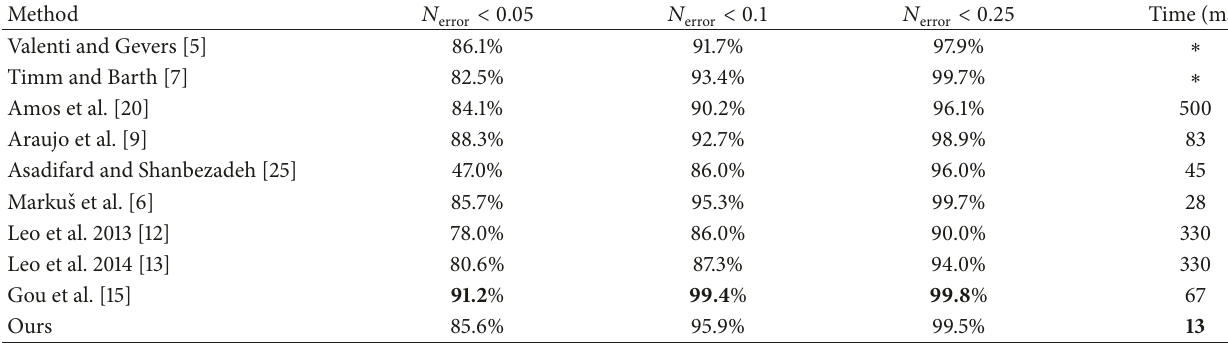
Table 2: Eye localization and classification comparison on the BioID datasets.